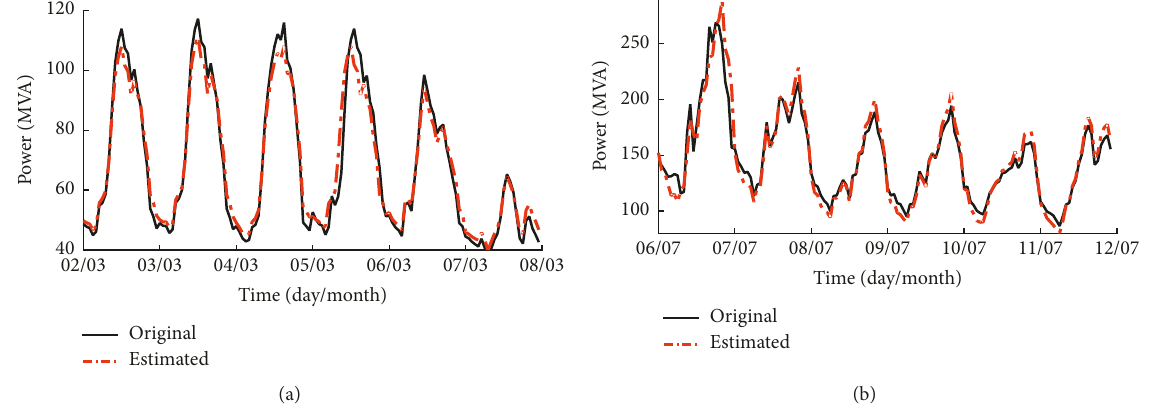
Figure 18: Comparison between original load shape and estimated load shape in one week for the load with the largest estimation error: (a) valley week; (b) peak week.